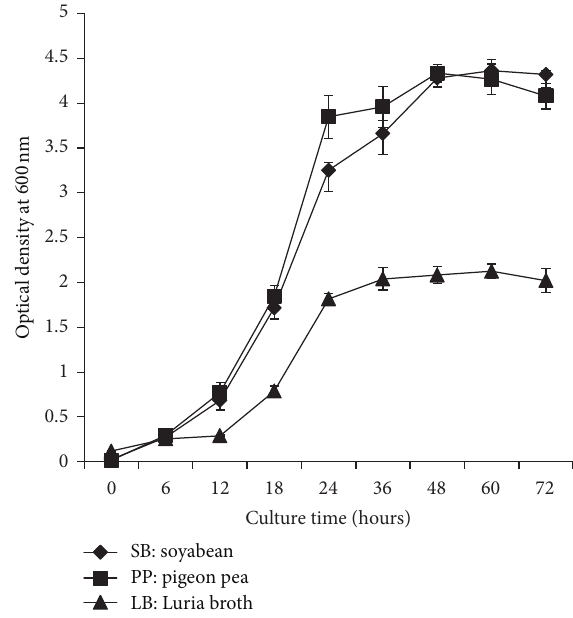
Figure 1: Growth pattern of Bt 𝑠 V 2 produced in different